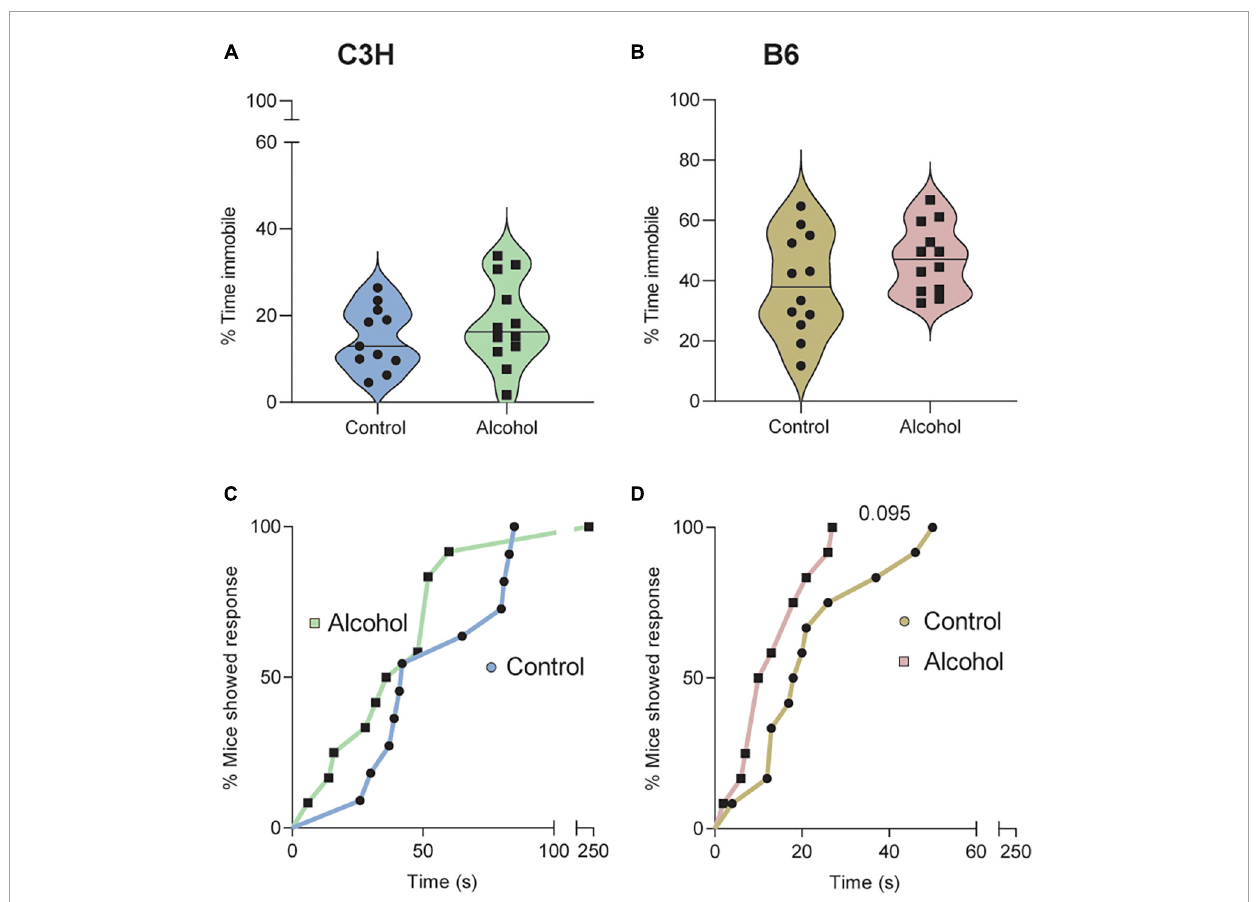
FIGURE7 Trend for depressive-like effects of alcohol exposure and subsequent withdrawal in the tail suspension test. The % of time spent immobile (A,B) and the latencies in seconds to first immobility (C,D) were assessed in C3H and B6 mice. Data are shown as individual subjects with violin plots (A,B) . Latencies are shown as the % of mice showing a response as a function of time (C,D) . Note the truncated ordinate in panel (A) and truncated abscissa in panels (C,D) . n = 12 per